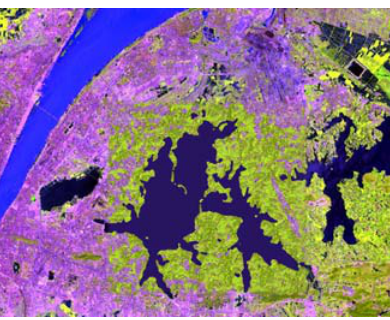
Figure 8. Translation of lake class